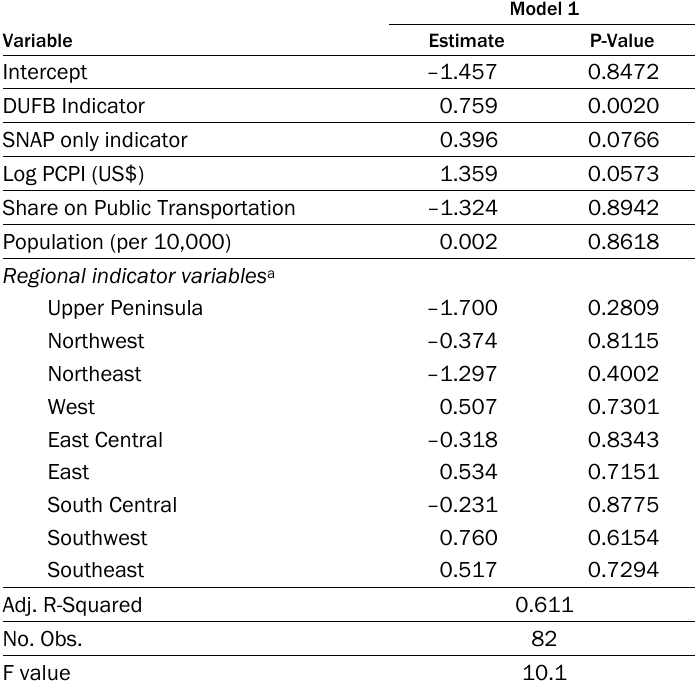
Table 4. Regression Results for Log Direct Sales Model 1,